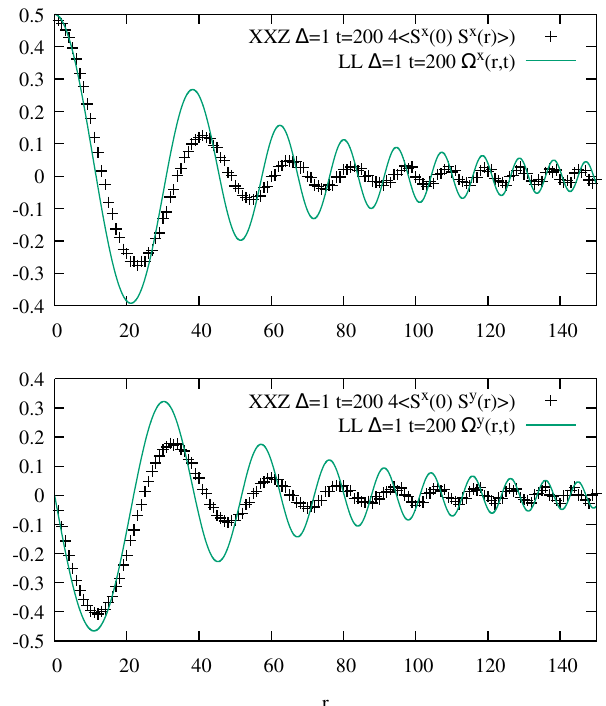
Figure 12: Comparison between some two-point correlations in the spin- 1 Ω x , y ( r , t ) in the isotropic LL problem. Upper panel: Ω x versus 〈 ˆ S x ( 0 ) ˆ S x ( r (cid:54) = 0 ) 〉 . Bottom panel: Ω y versus 〈 ˆ S x ( 0 ) ˆ S y ( r (cid:54) = 0 ) 〉 . Both taken at time t = 200. See Sec.